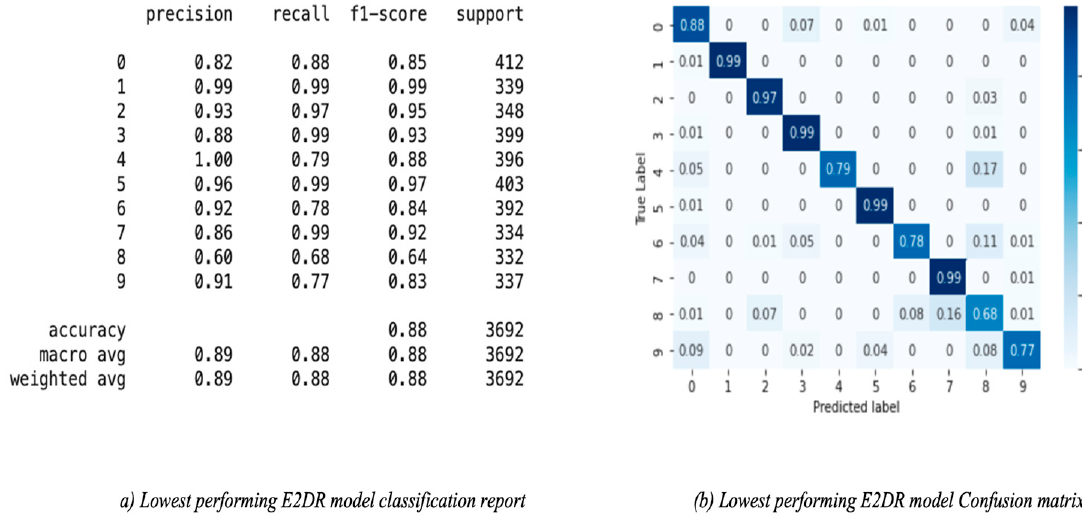
Figure 15. Lowest performing E2DR model classification report and confusion matrix.